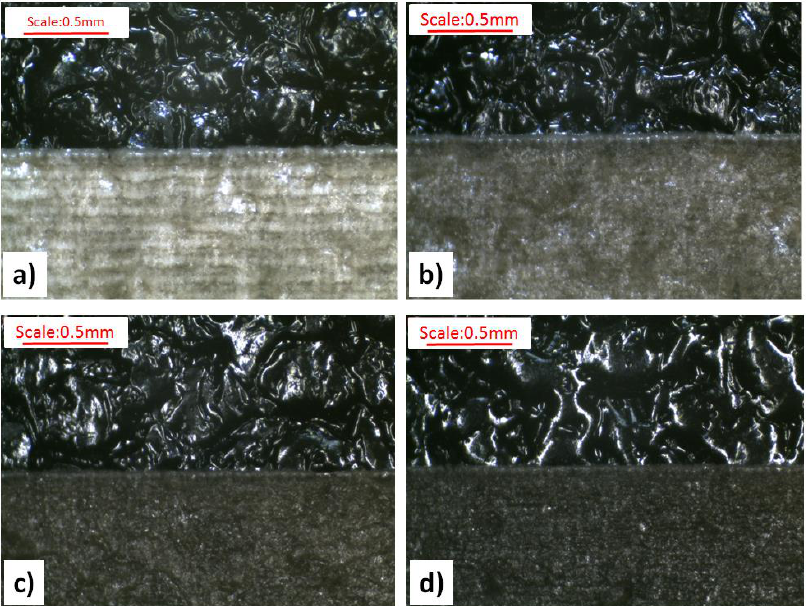
Figure 7. Influence of the Lifolas M Schwarz 113504 UN laser marking additive content on the condition of the DC surface before and after the marking with velocity B (750 mm·s −1 ): ( a ) 0.0 wt % content, ( b ) 0.5 wt % content, ( c ) 1.5 wt % content, and ( d ) 2.5 wt % content.